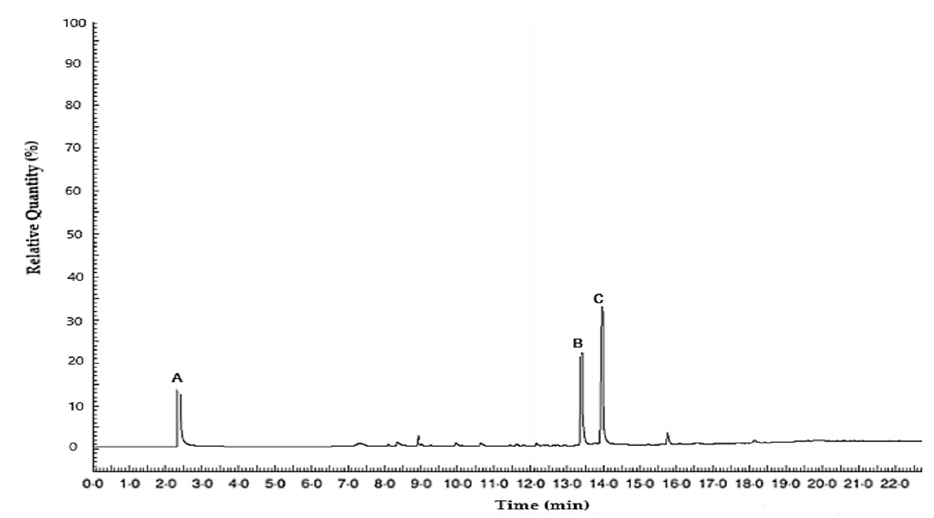
Figure 2. Chromatogram of the essential oil from lemongrass. The first peak (A) represents myrcene, the second peak (B) represents neral, and the third peak (C) represents